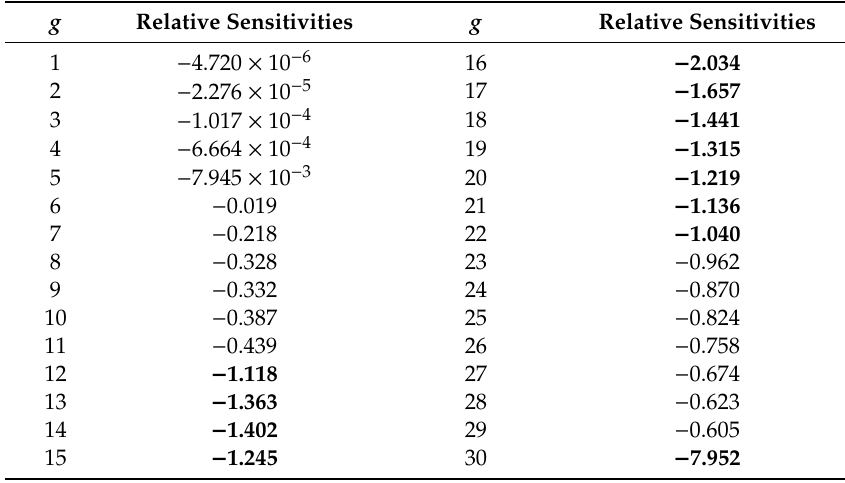
(cid:16) (cid:17) N 1,1 , σ g , g = 1, ... t ,5